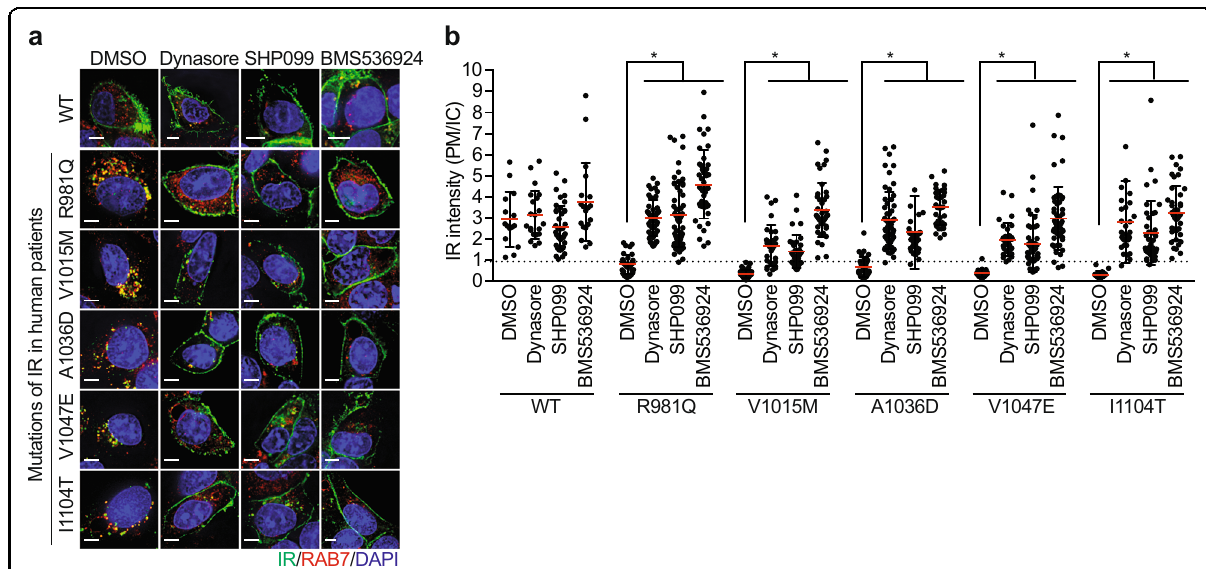
Fig. 4 Characterization of class II IR mutations found in human patients. a HepG2 cells stably expressing IR-GFP WT or Class II mutants were serum starved for 14 h, treated with the indicated inhibitors for 4 h, and stained with anti-GFP (IR; green) and anti-RAB7 (Red; D95F2, Cell Signaling) antibodies. Dynasore (dynamin inhibitor, 80 μ M, Sigma), SHP099 (SHP2 inhibitor, 10 μ M, MedChemExpress), and BMS536924 (IR kinase inhibitor, 2 μ M, Tocris). Scale bar, 5 μ m. b Quanti fi cation of the ratios of PM and IC IR-GFP signals of the cells shown in a (mean ± SD; * p <